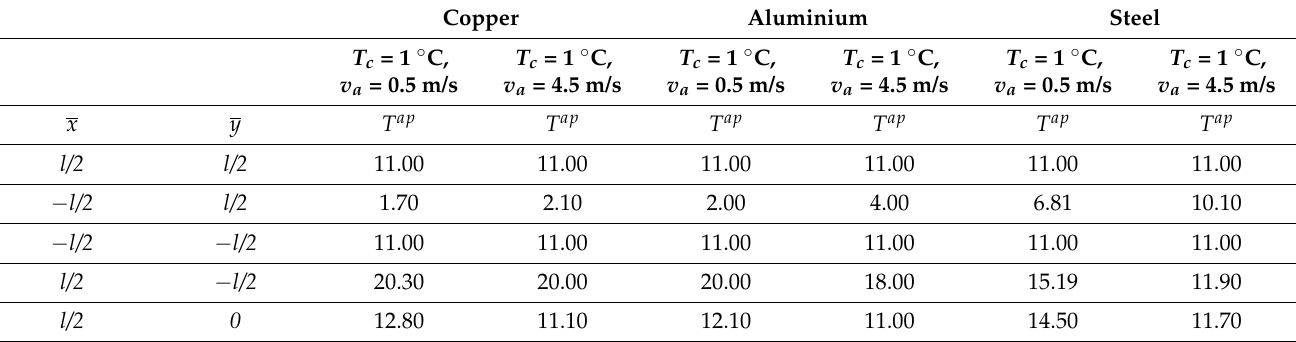
Table 10. Temperatures in the corners of different plates and at the midpoint of the plate’s surface facing the heated air inlet to the room for different values of T c , v a , t = 300 s, and T c = 1 ◦